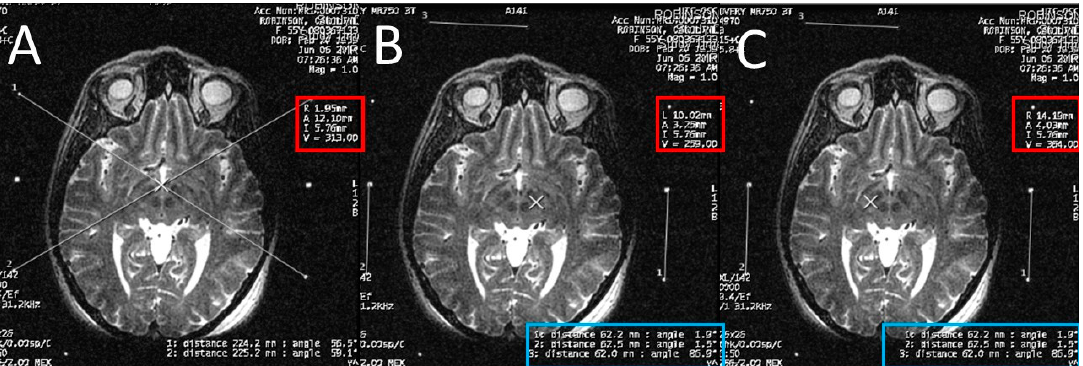
Figure 5. Calculating the subthalamic nucleus (STN) coordinates from the magnetic resonance imaging (MRI) console. ( A ) Two diagonal lines intersecting at the center of the frame at the STN level with MRI coordinates of the center of the frame shown inside the red square; ( B ) a crosshair at the center of the left STN, with its MRI coordinates shown inside the red square; two lines are drawn between the middle and lower fiducials on both sides of the frame and their lengths (in the blue rectangle) are used to calculate the Z coordinate; ( C ) a crosshair at the center of the right STN, with its MRI coordinates shown inside the red square; two line are drawn between the middle and lower fiducials on both sides of the frame and their lengths (in the blue rectangle) are used to calculate the Z coordinate.